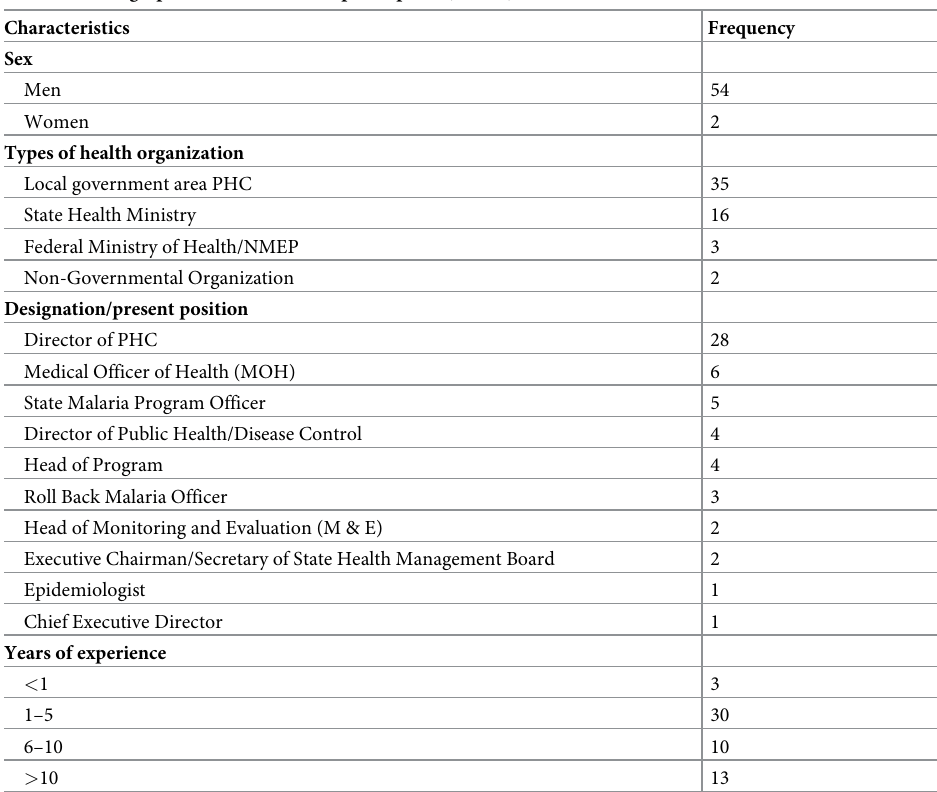
Table 1. Demographic characteristics of participants (N =